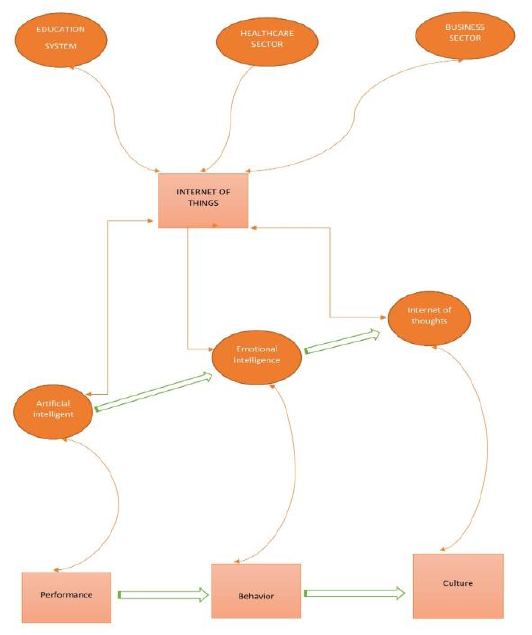
Figure 5. Stages of internet of